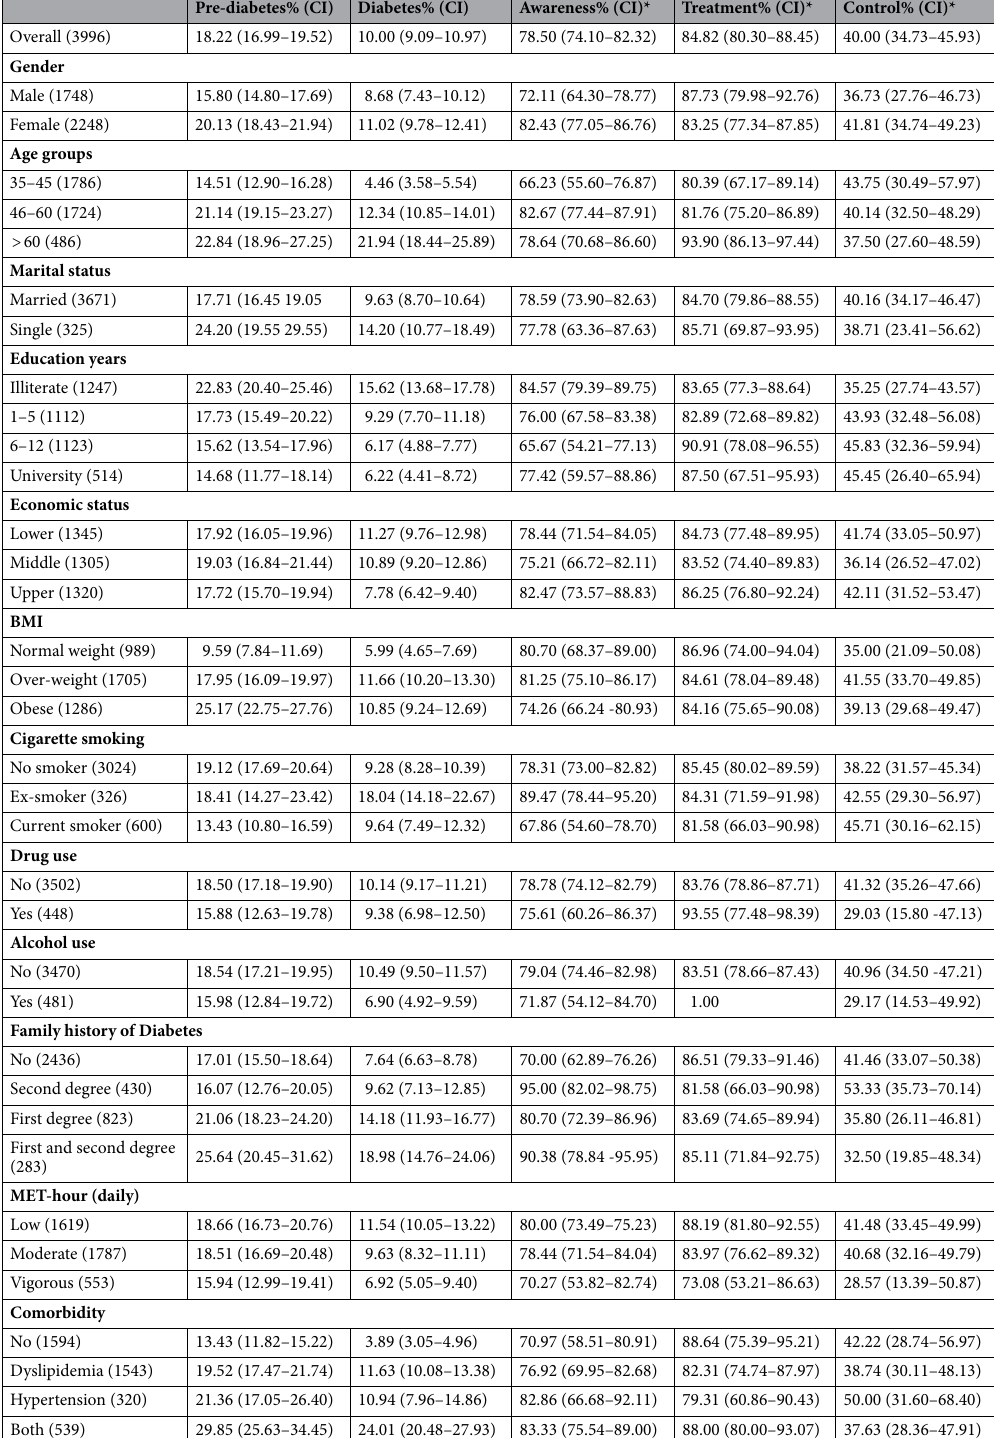
Table 1. Prevalence of pre-diabetes, diabetes, awareness, treatment, and FBS control across different groups in DehPCS. *Each proportion were calculated based on the previous